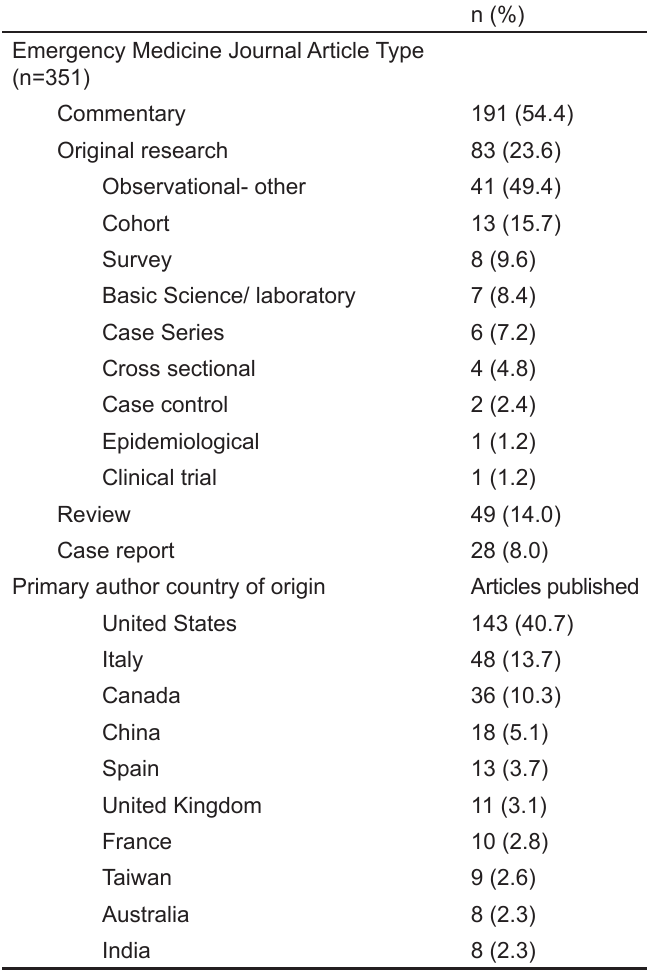
Table 2. Characteristics of the 20 top-ranked emergency